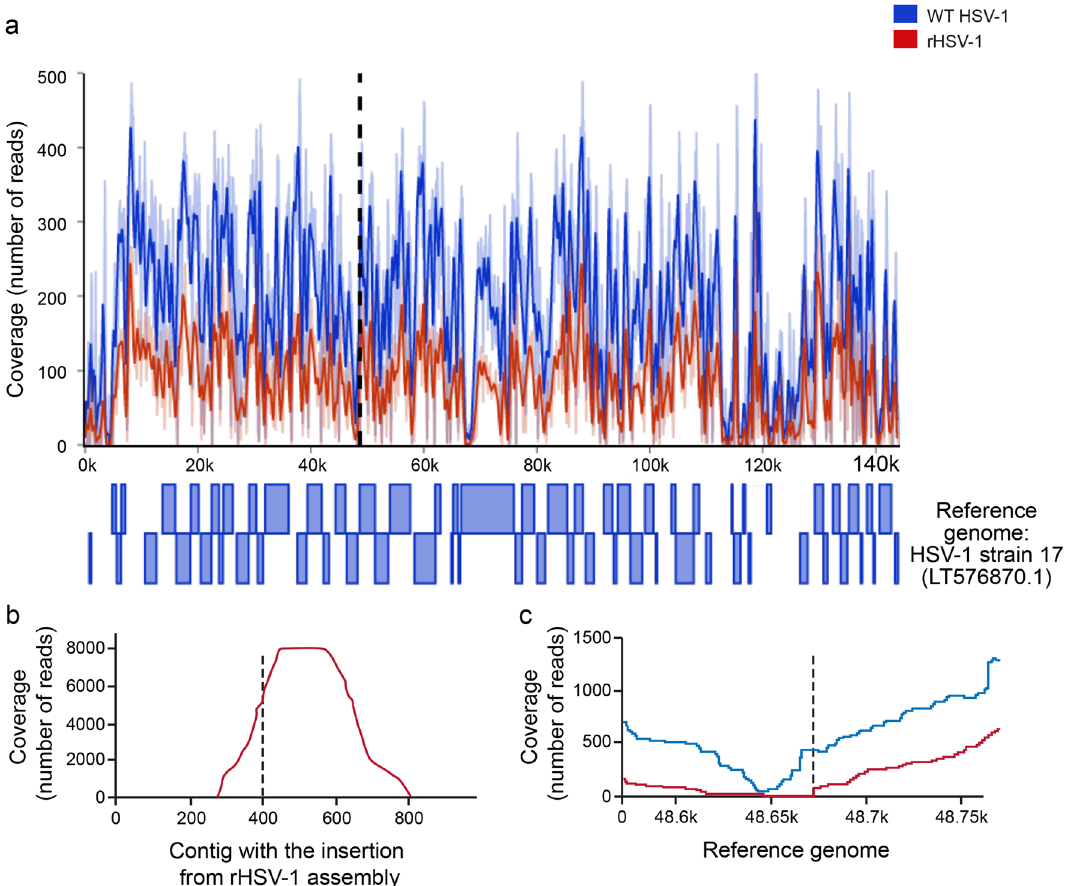
Figure 3. Sequencing depth (Coverage (number of reads) from high-throughput sequencing of the whole genome and the insertion junction. ( a ) Average sequencing depth over 500 bp. after alignment of HSV-1 strain H25 (blue) and recombinant HSV-1 (rHSV-1) (red) on reference genome of HSV-1 strain 17. The dash line represents the expected insertion junction. ( b ) Sequencing depth of the multiplexed PCR library over the contig from rHSV-1 that contains the insertion. The PCR clearly shows that the expected junction is amplified. ( c ) Zoomed view from ( a ) to better compare the sequencing depth at the expected insertion position from HSV-1 strain 17. There are no reads from rHSV-1 that overlap the insertion point but coverage increases right after, suggesting a successful